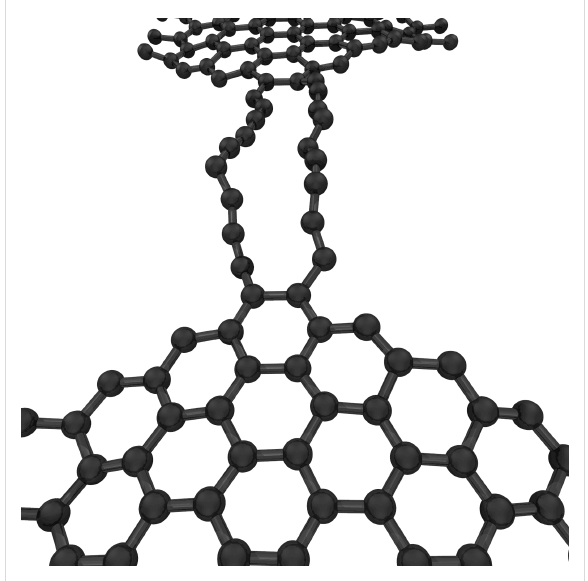
Figure 6: Formation of a pair of carbon chains during the breakage of a graphene ribbon under electron irradiation. The calculation shows the effect of continuous atom removal from a graphene sheet. Cour- tesy of J.